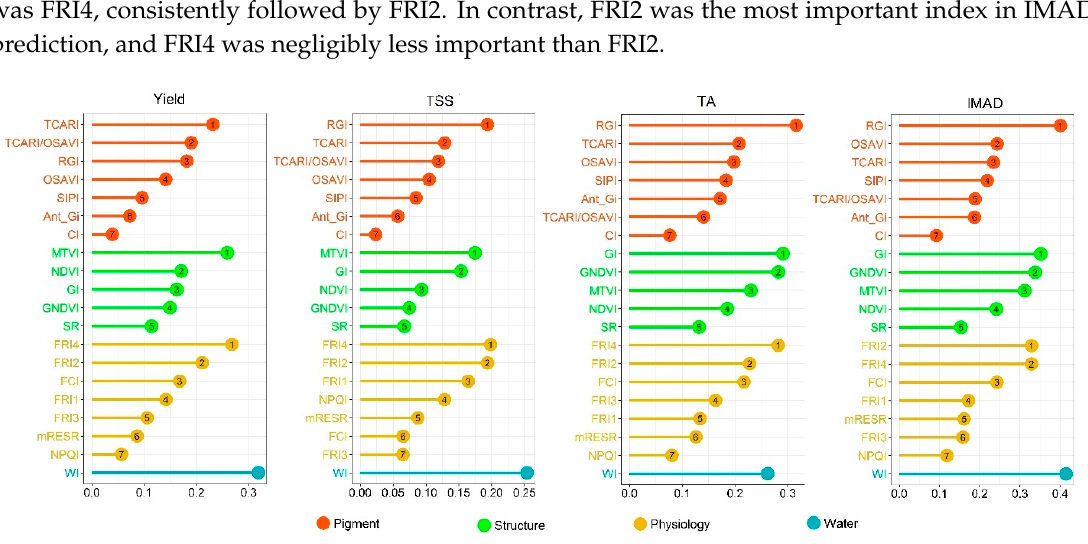
Figure 7. ELM-based best models showing the relative importance of vegetation indices in the prediction of berry yield and quality parameters. Indices within each category were ranked by importance. The higher the importance value (IV) the more important the